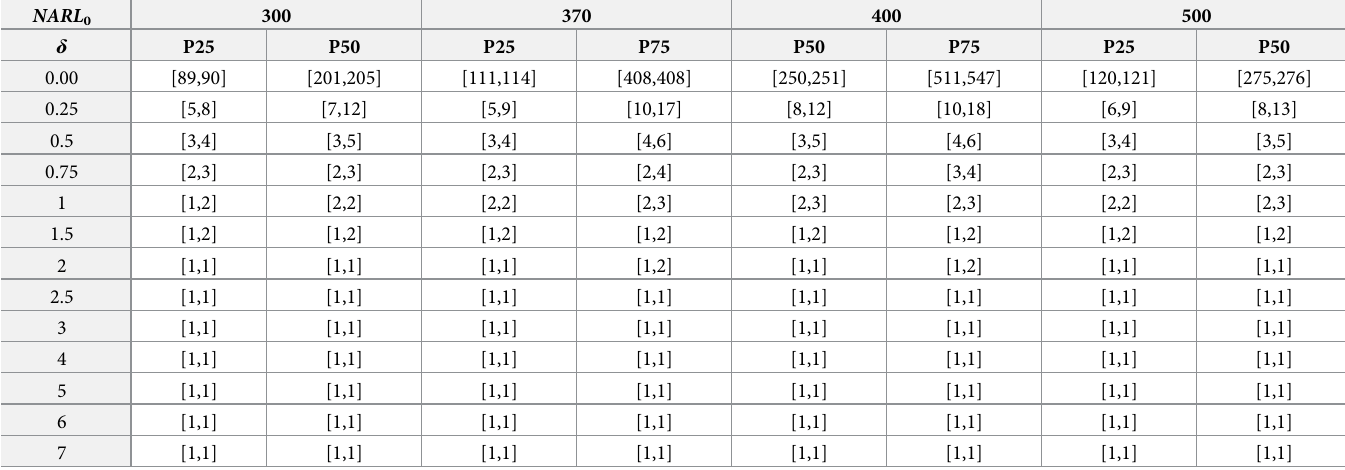
Comparison of the proposed NCUSUM � X and classical CUSUM � X charts. The persis- tent need for more awareness of the proposed NCUSUM � X chart, comprehensive comparison has been made with classical CUSUM � X chart. To get valid deductions, the in-control ARL s of both charts are set at nominal levels of 370 and 500, and the performance is compared in terms of the out-of-control ARL s and SDRL s. The strategy of working in this section is parallel to [27], that is, a control chart under neutrosophic design is said to be capable if it has smaller NARL values compared to its counterpart. Thus, the efficiency of the proposed chart in terms Table 6. The neutrosophic percentile points of the proposed NCUSUM � X chart when n 2 [10, 20], k 2 [0.4, 0.5] for different nominal NARL . N N NARL 0